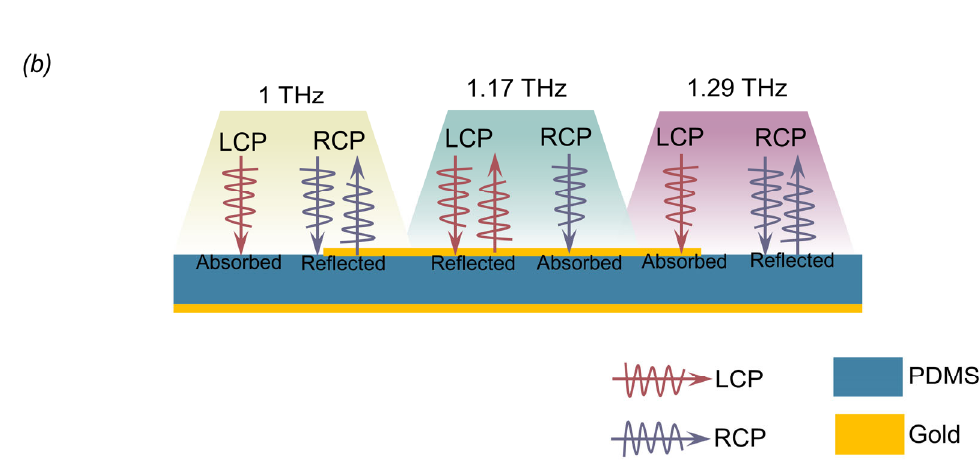
Figure 1. ( a ) Model and structural parameters of the T-SRR unit cell and the four kinds of chiral metal strips; ( b ) Functional diagram of the T-SRR unit cell. Table 1. The dimension parameters of the T-SRR metal